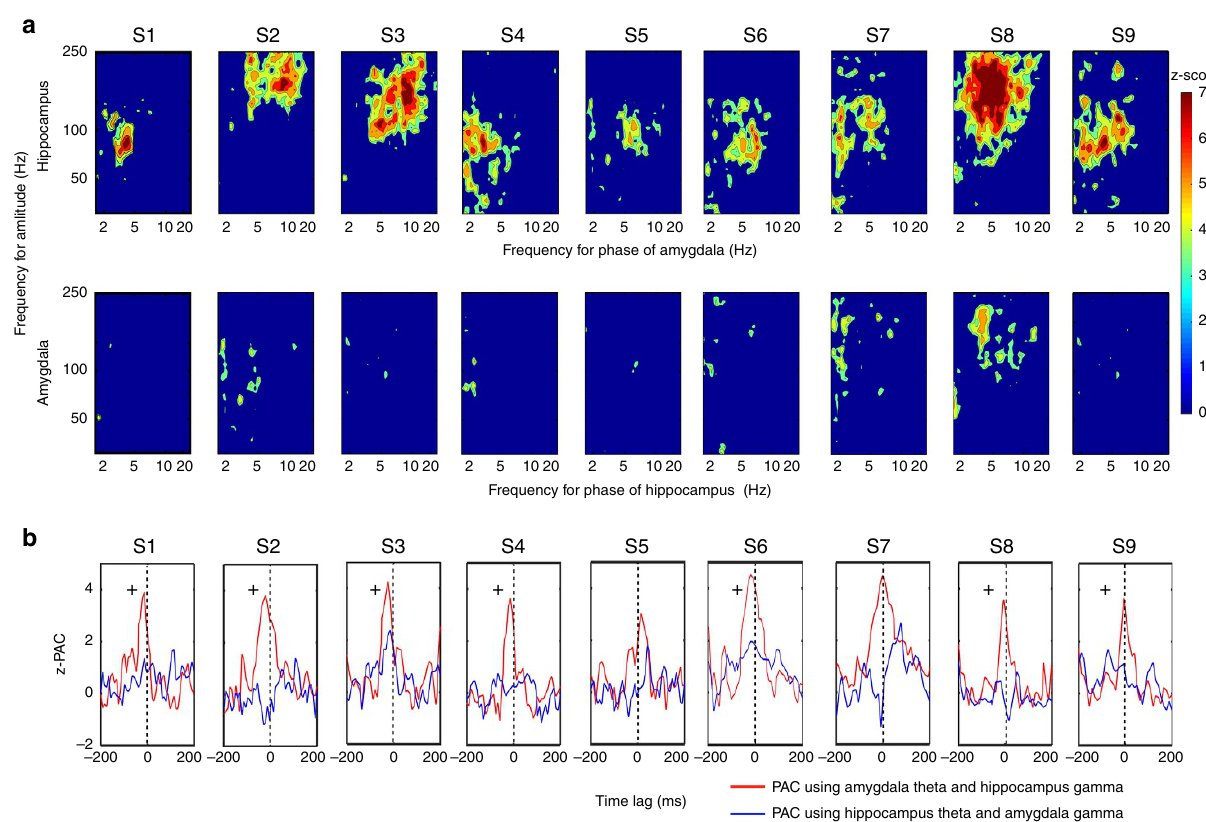
Figure 3 | Amygdala-hippocampus directional PAC and phase lag analysis. ( a ) PAC comodulogram for differences between the aversive and the neutral conditions is shown, with warmer colours denoting higher z -scores. The high gamma amplitude in the hippocampus was phase-locked to the phase of amygdala low-frequency (theta and alpha) rhythms (all P o 0.01, permutation test). In contrast, the reciprocal directional PAC modulation (for example, high gamma amplitude in the amygdala phase-locked to phase of hippocampal low-frequency activity) was nearly absent. ( b ) Phase lag analysis. The PAC modulation index between low-frequency phase and high gamma amplitude was estimated across time lags for the aversive condition. The red line represents the z -PAC between subject-specific amygdala low-frequency phase and hippocampal high gamma amplitude (70–180Hz). The blue line denotes the z -PAC between hippocampus low-frequency phase and amygdala high gamma amplitude. Cross ( þ ) denotes subjects who showed the amygdala low-frequency activity leading hippocampal